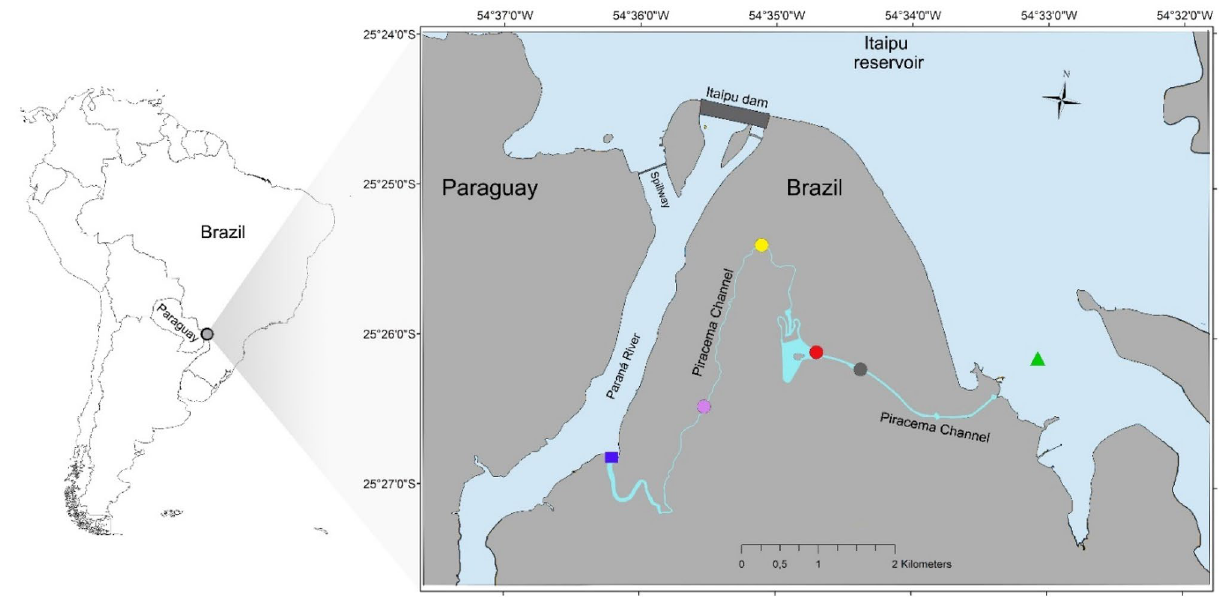
Figure 1. Sampling location. The map shows the sampling location of each collection point. We sampled one point at mouth of channel at Paraná River (blue square), four points along the Piracema Channel (circles; Bela Vista River 1 = purple, Bela Vista 2 = yellow, Brasilia stream = gray, and lake = red), and one point at Itaipu’s reservoir (green triangle). Up at figure is possible to visualize the Itaipus’ dam that created the reservoir. Inset panel shows the location of Itaipu’s dam in relation to South America. Map was created in QGIS v.3.6.2 software 88 .